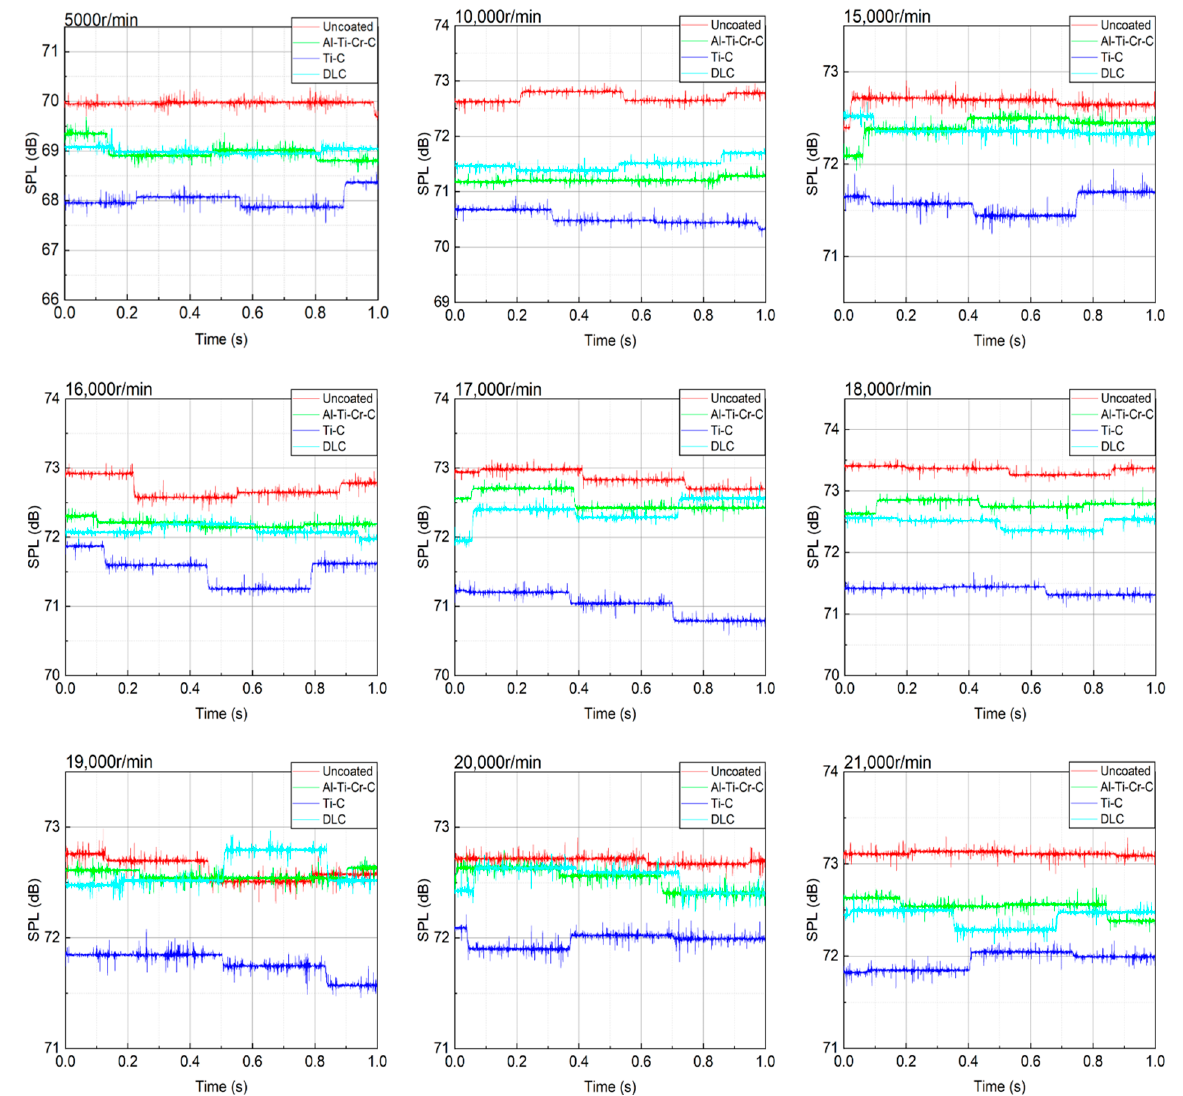
Figure 9. Sound pressure levels vs. Times of spindles at each speed .